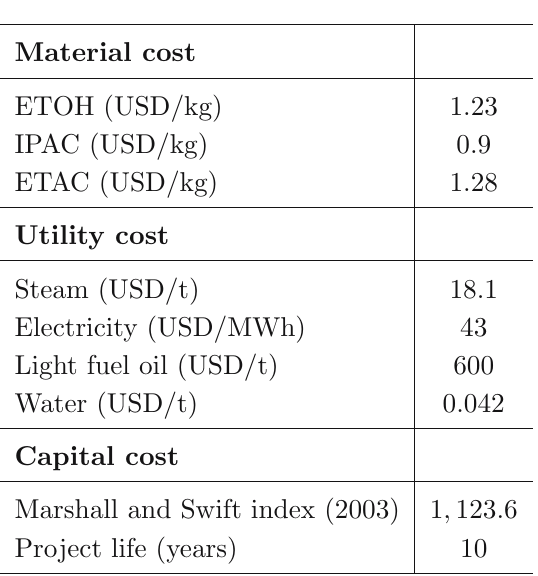
Table 2 Data used by the economic assessment.